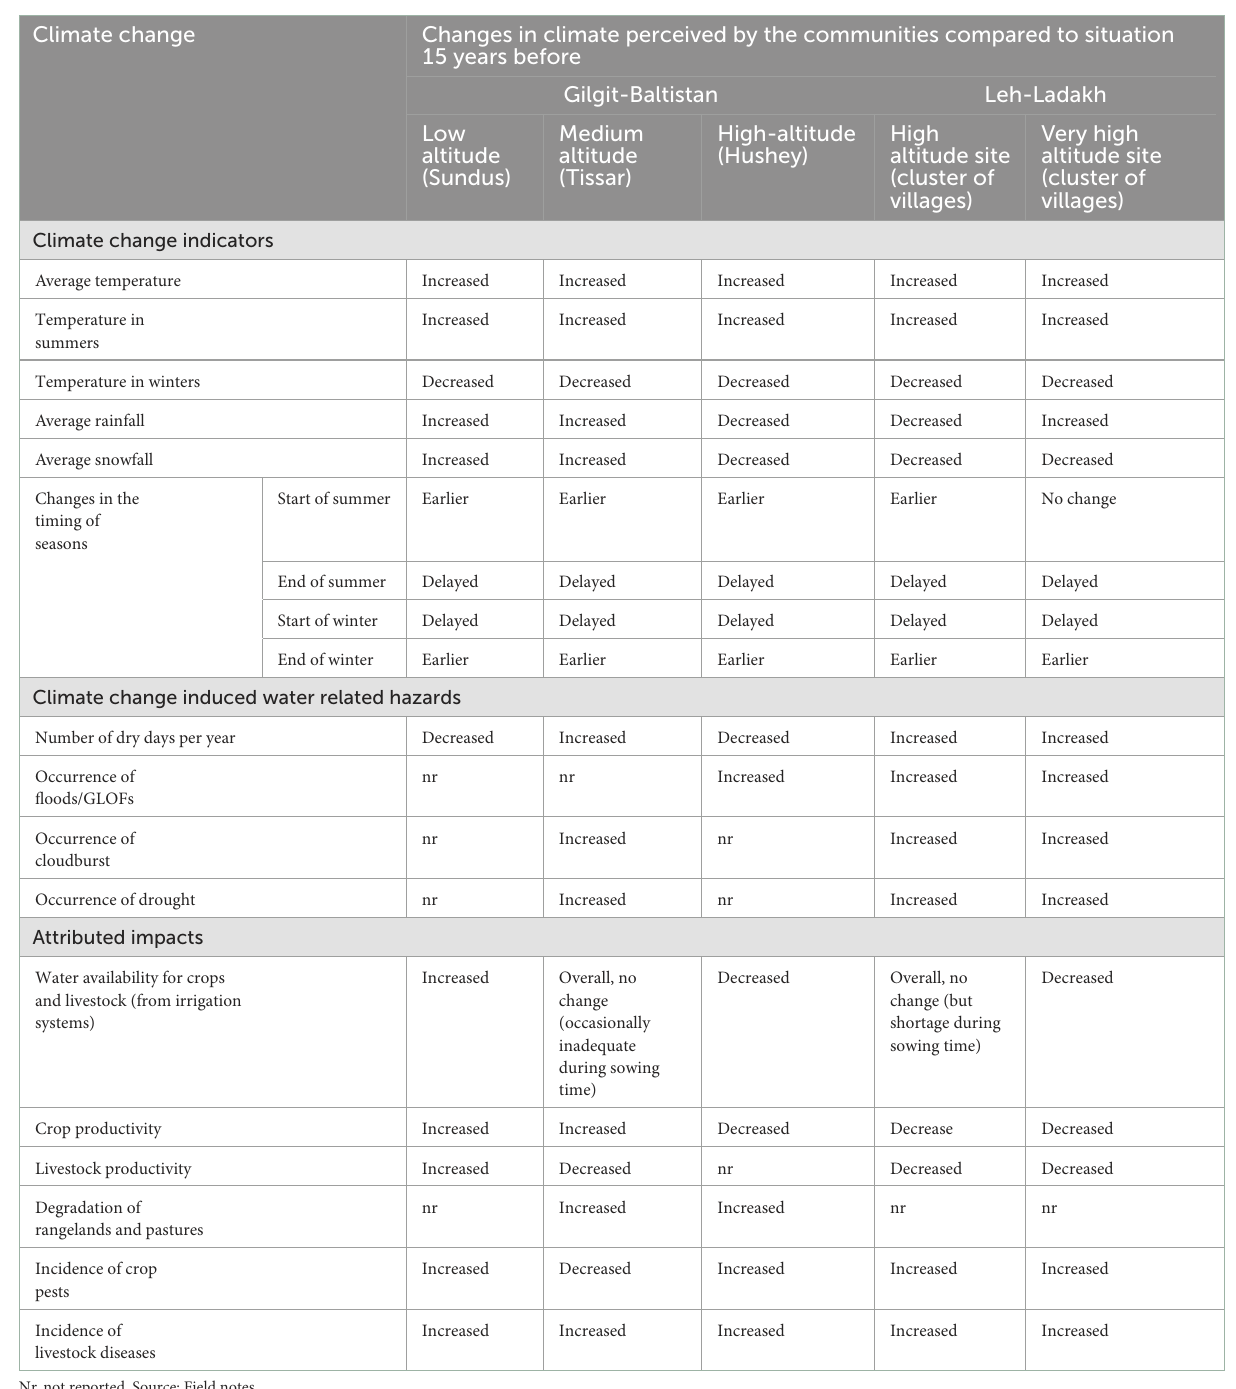
TABLE 4 Local people’s perceptions of climate change and water related